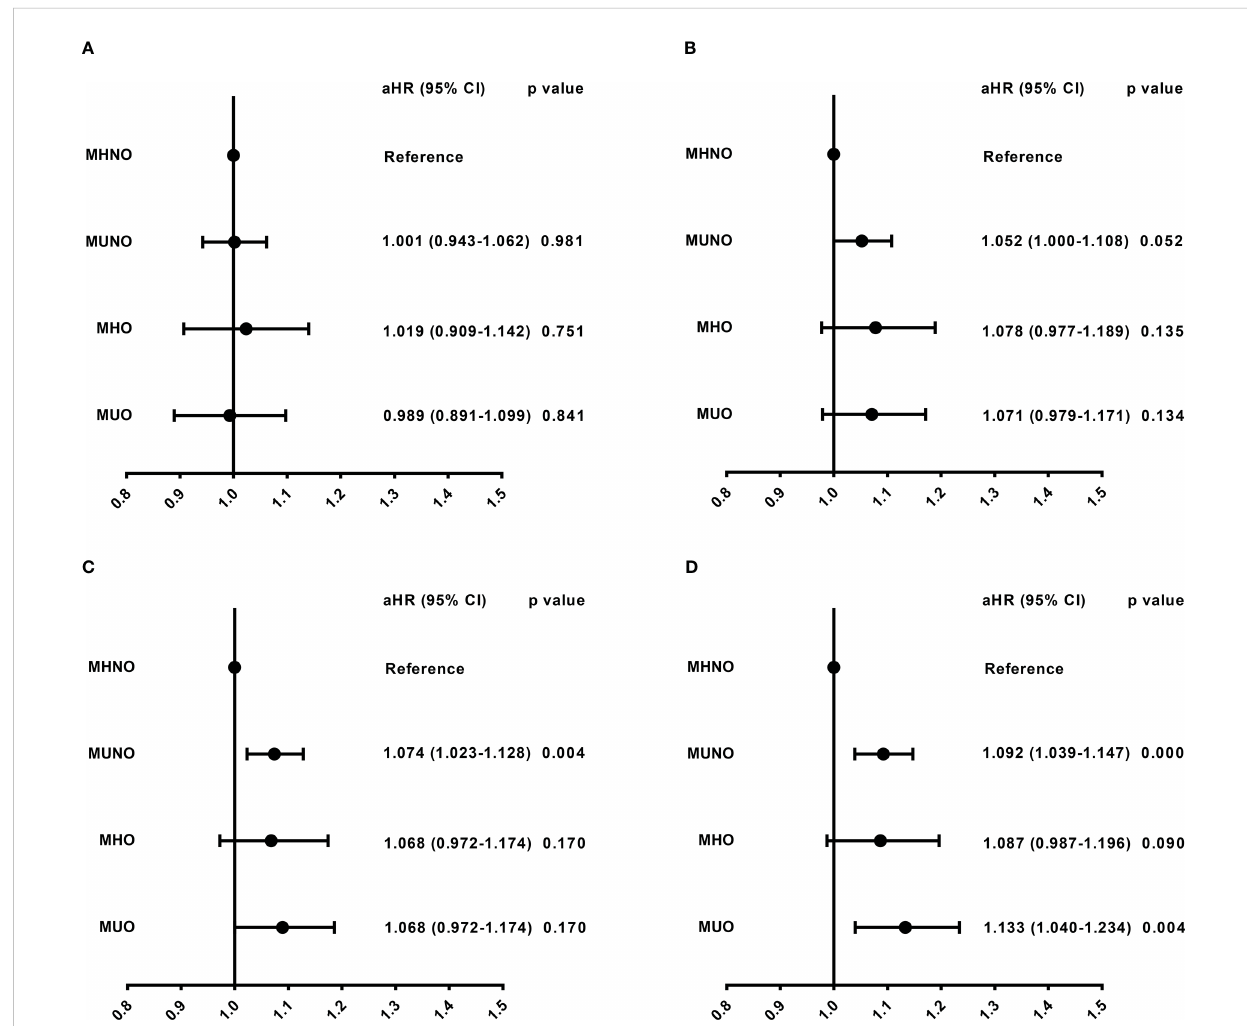
FIGURE 3 Readmission risk among different metabolic obesity phenotypes in four follow-up days. (A) Readmission risk in 30-day. (B) Readmission risk in 60- day. (C) Readmission risk in 90-day. (D) Readmission risk in 180-day. The model was adjusted for age, sex, elective admission, primary payer, disposition of patient, resident, length of stay, total charges, emergency record, same day events, patient location, antineoplastic chemotherapy, and stem cells transplant status. aHR, adjusted hazard ratio; CI, con fi dence interval; MHNO, metabolically healthy non-obese; MUNO, metabolically unhealthy non-obese; MHO, metabolically healthy obese; MUO, metabolically unhealthy